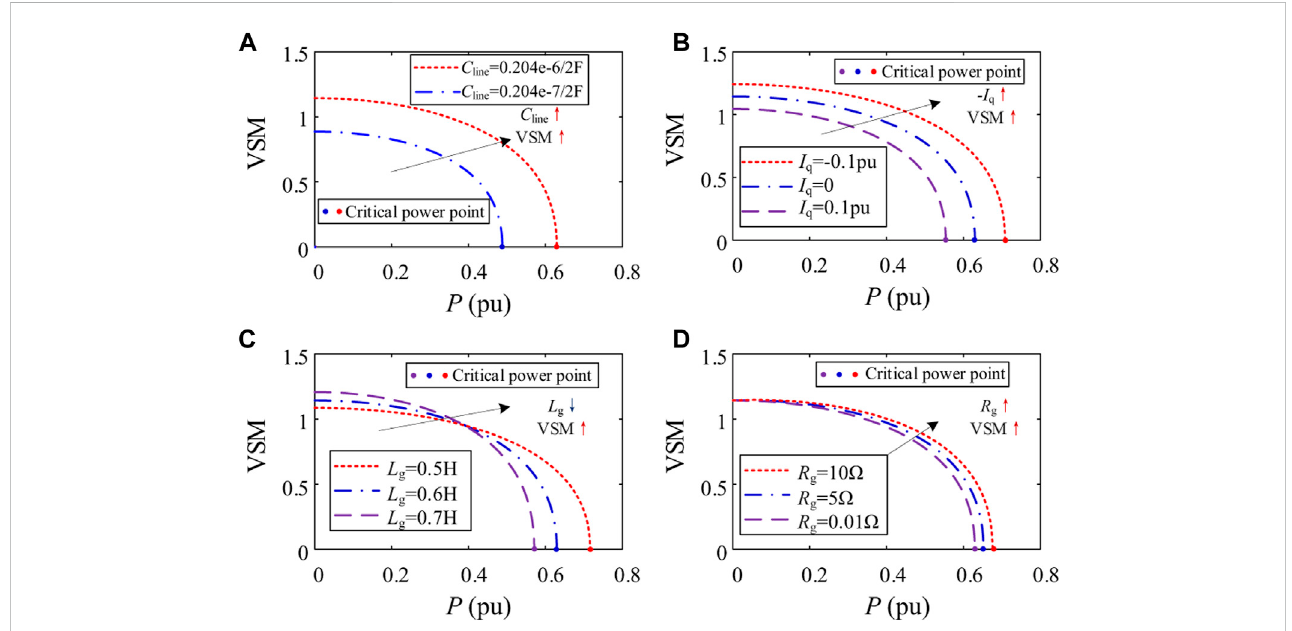
FIGURE 7 VSM curve under different parameters, (A) Cable capacitance parameters ( C line ), (B) Output reactive current ( I q ). (C) Grid inductance ( L g ), (D) Grid resistance ( R g ).